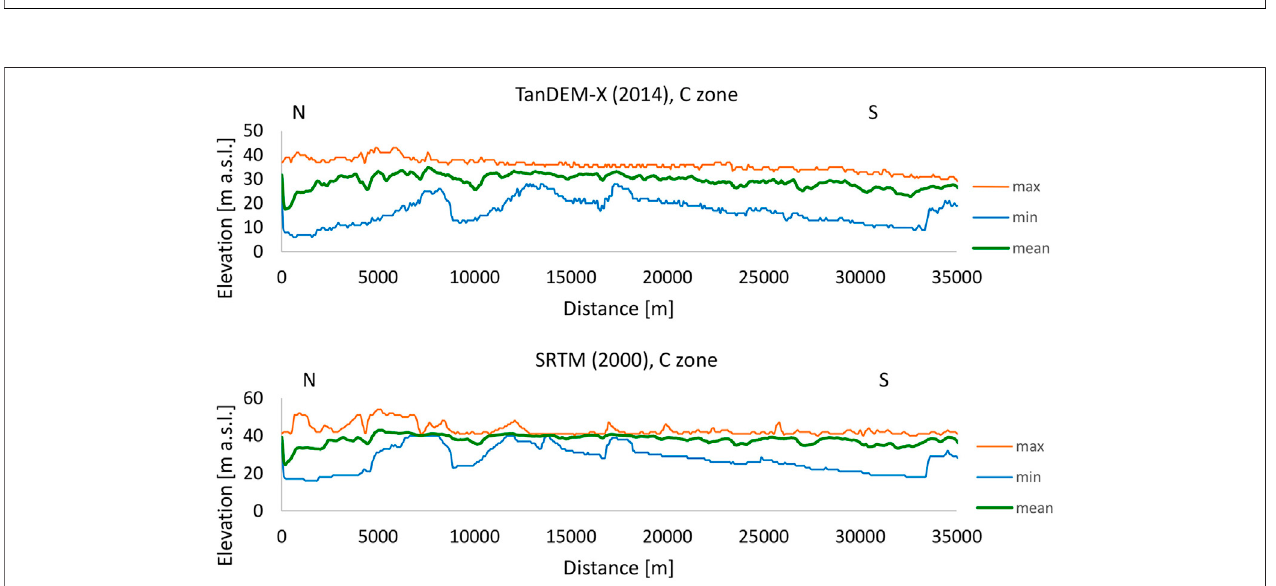
FIGURE 8 | North-South swath pro fi les across the hot spot zone C. Elevation min, max, and mean values are derived from TanDEM-X and SRTM DEM data. The mean elevation values up to 2 m net mass loss over 14 years.